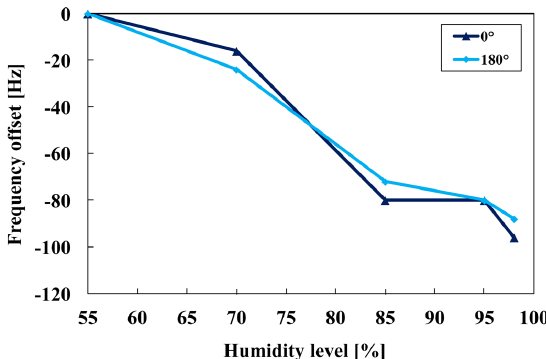
Figure 21. Measured frequency o ff set on a single resonator due to di ff erent humidity levels (humidity level increased every 30min, gap: